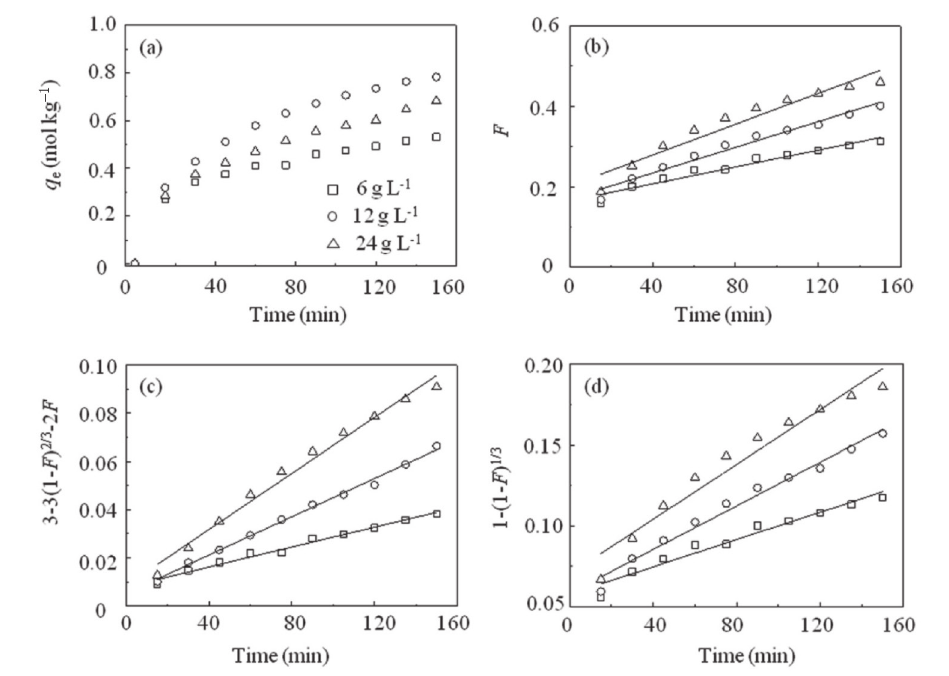
Fig. 6 – Experimental data and shell progressive model fitting for adsorption of D-GA onto the resin with varying initial concentrations (a) experimental data (b) fluid film control (c) diffusion control (d) chemical reaction control Table 5 – Linear regression analysis of SPm model for D-GA uptake at varying initial concentrations